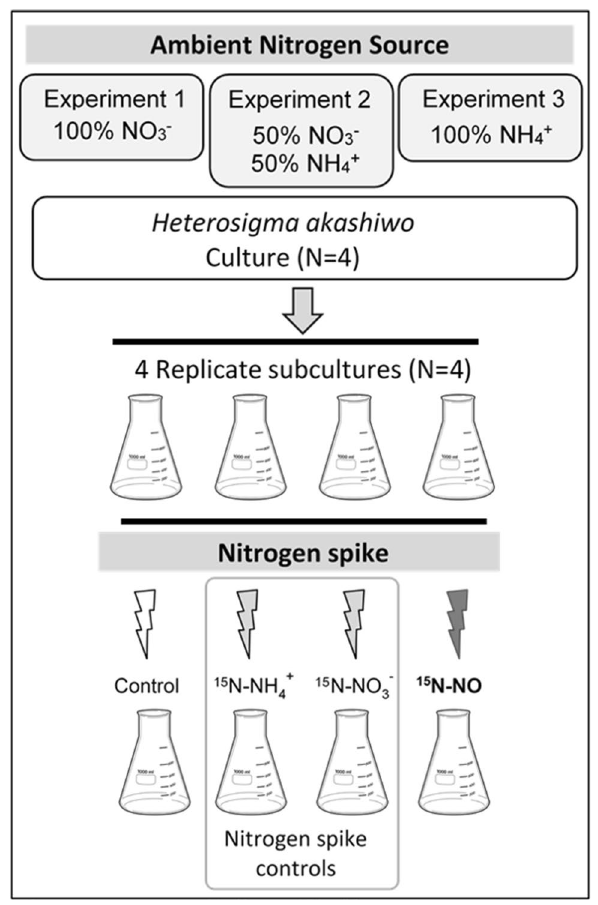
Figure 1. Experimental design. Heterosigma akashiwo was cultured with 100 µM nitrate (Experiment 1), 50 µM nitrate and 50 µM ammonium (Experiment 2), or 100 µM ammonium. Cultures (N = 4) were then subdivided into four treatments for a total of 16 subcultures for each experiment. Controls received nitrogen free medium. Nitrogen-spiked controls received 15 N-labelled nitrate or ammonium at 10% of ambient concentrations (see Table 1), and the NO treatment was spiked with 100 µM 15 N-labelled S-nitroso-N-acetylpenicillamine (SNAP) to generate 15